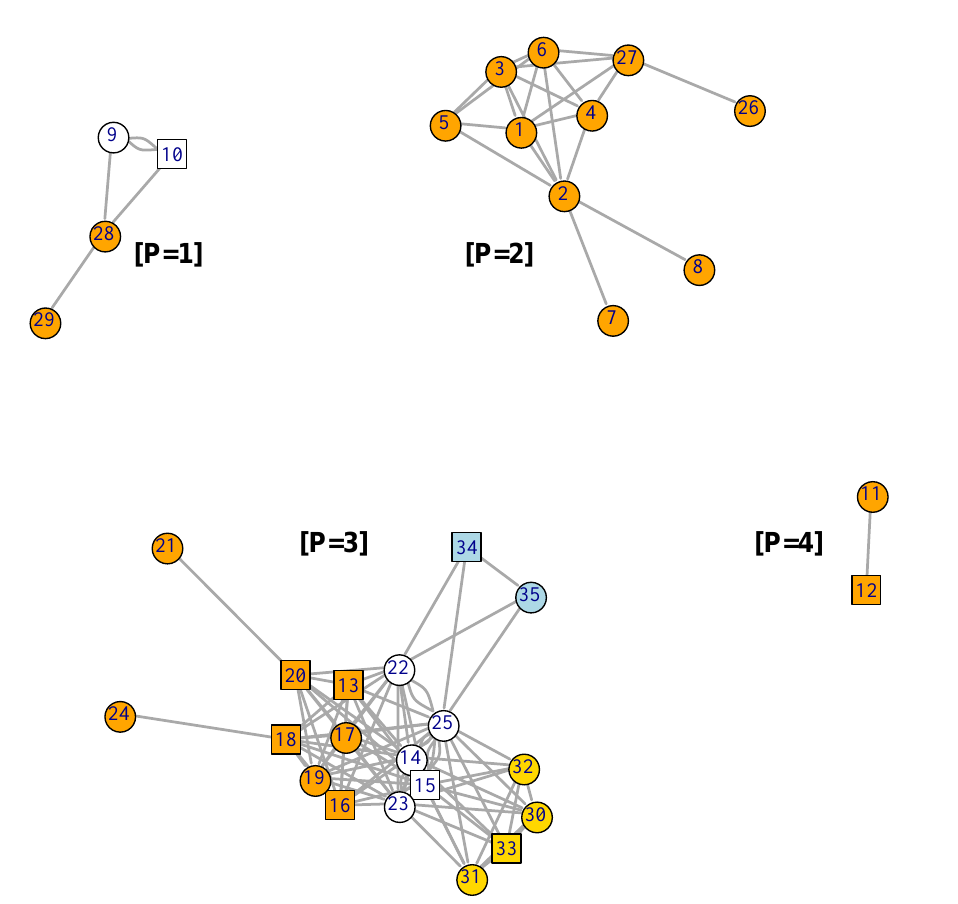
Figure 6. Graph of the MN formed by the 3 GFN. Genes found exclusively in BP celcy are colored in orange, the ones exclusively in rep are colored in golden yellow, and the ones exclusively in vir are colored in blue, while genes shared by two or more BP are in white. Disconnected sub-networks are annotated with labels [P = 1] to [P = 4] (Supplementary SI.5 for gene